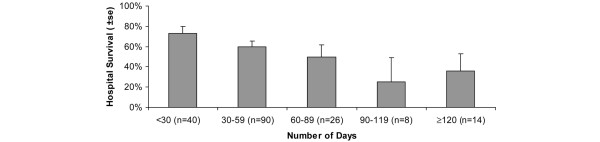
Hospital survival by number of ventilator days. se, standard error.